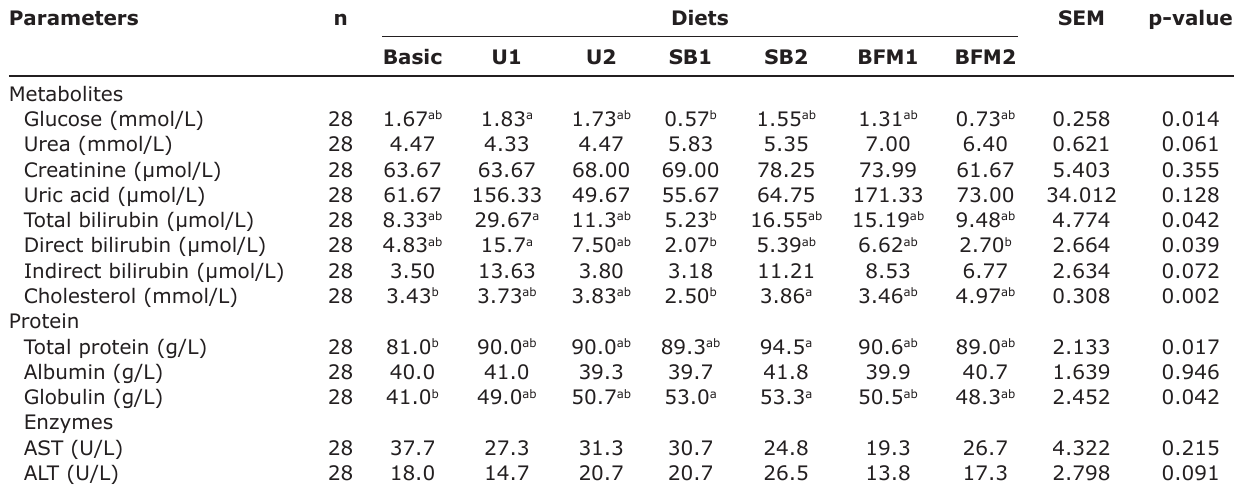
Table-1: Enzyme activities and concentrations of proteins and metabolites in blood of cattle supplemented with different protein sources and levels (n=28) . Parameters